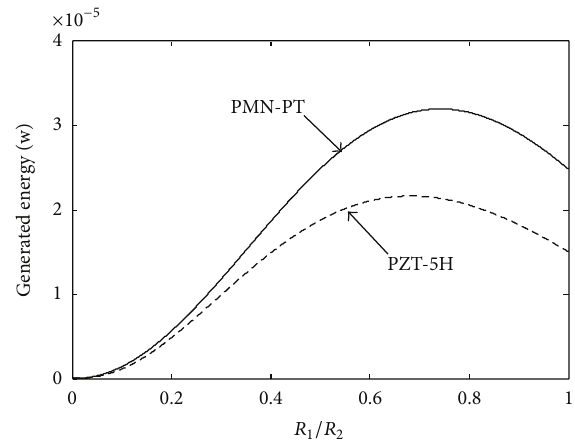
Figure 5: Effect of piezoelectric material on generated energy in the case of simple support ( 𝑅 2 = 20 mm) (Section 2.1).